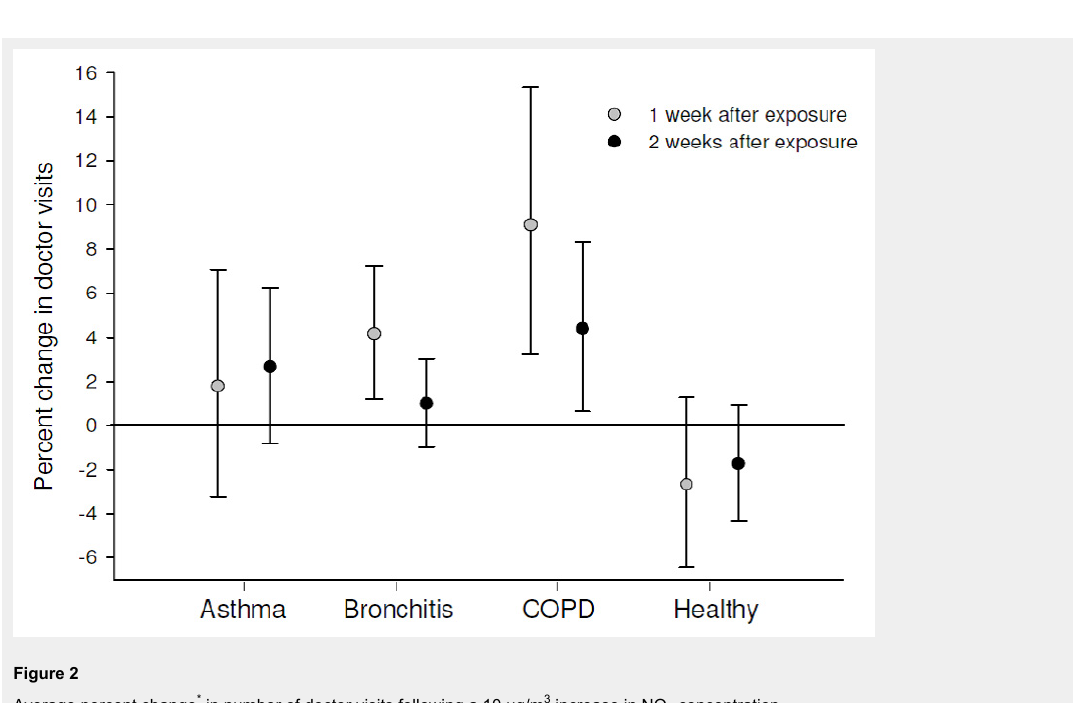
Figure 2 Average percent change * in number of doctor visits following a 10 µg/m 3 increase in NO 2 concentration. * For each subgroup, areas under the curve were estimated from adjusted conditional logistic regression models to approximate the average percent change in number of doctor visits over 1 and 2 week periods following a 10 µg/m 3 increase in exposure to NO 2 concentration on a given